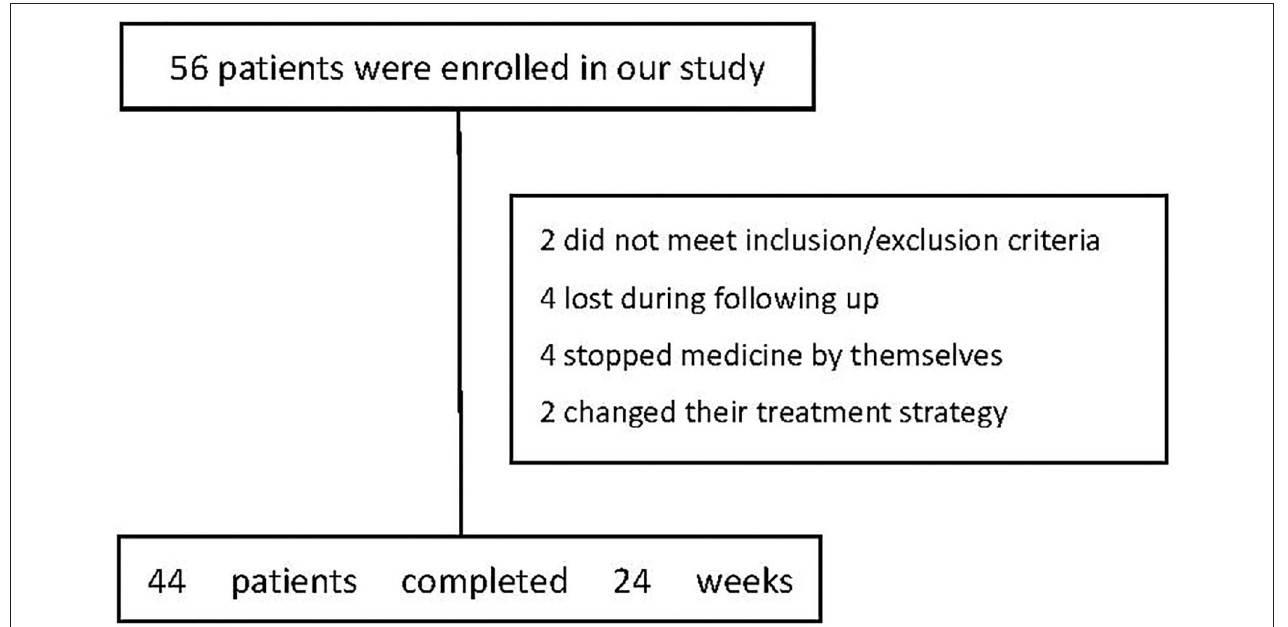
FIGURE 1 | The flow chart of patients at baseline and 24 weeks after treatment.